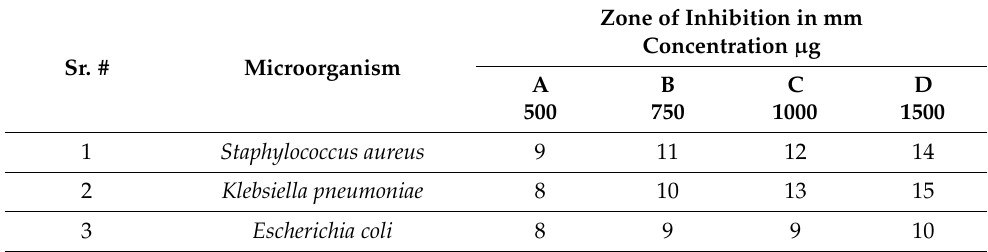
Table 5. ZnO NPs zone of inhibition in mm.